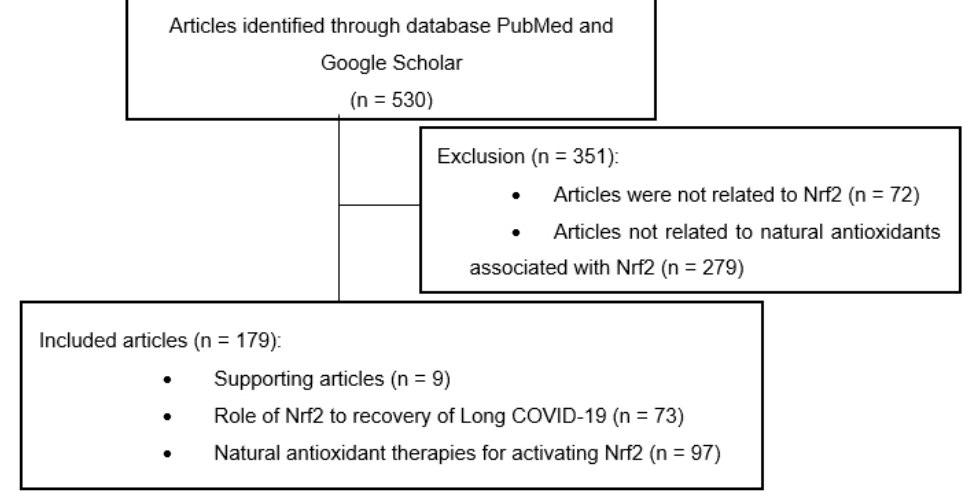
Figure 1. Literature search flow chart.